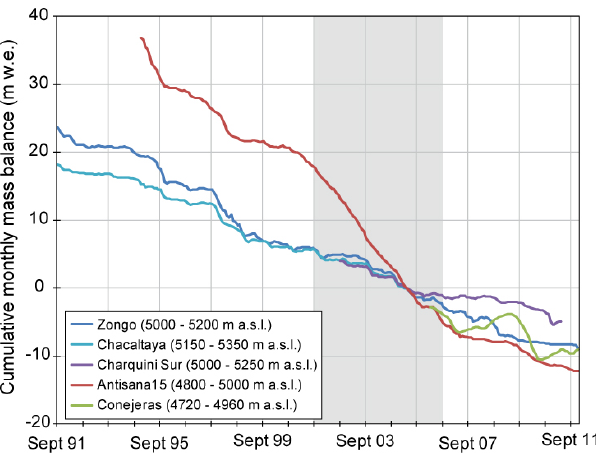
Fig. 8. Cumulative monthly mass balance for five glaciers in the tropical Andes where the measurements were made at this timescale (the reference time for the cumulative time series is April 2005, ex- cept for Conejeras Glacier where measurements began in March 2006). Zongo, Chacaltaya and Charquini Sur glaciers are located in Bolivia, in the outer tropics, while Antisana 15 and Conejeras glaciers are located in Ecuador and Colombia, in the inner tropics, respectively. Note that for Zongo and Antisana 15 glaciers, only the results of the ablation zone are plotted. Monthly mass balance mea- surements on Chacaltaya Glacier were stopped in September 2005 because the glacier was too small. The light grey box highlights the 2001–2006 period when mass balance of Antisana 15 Glacier was negative, diverging from the outer